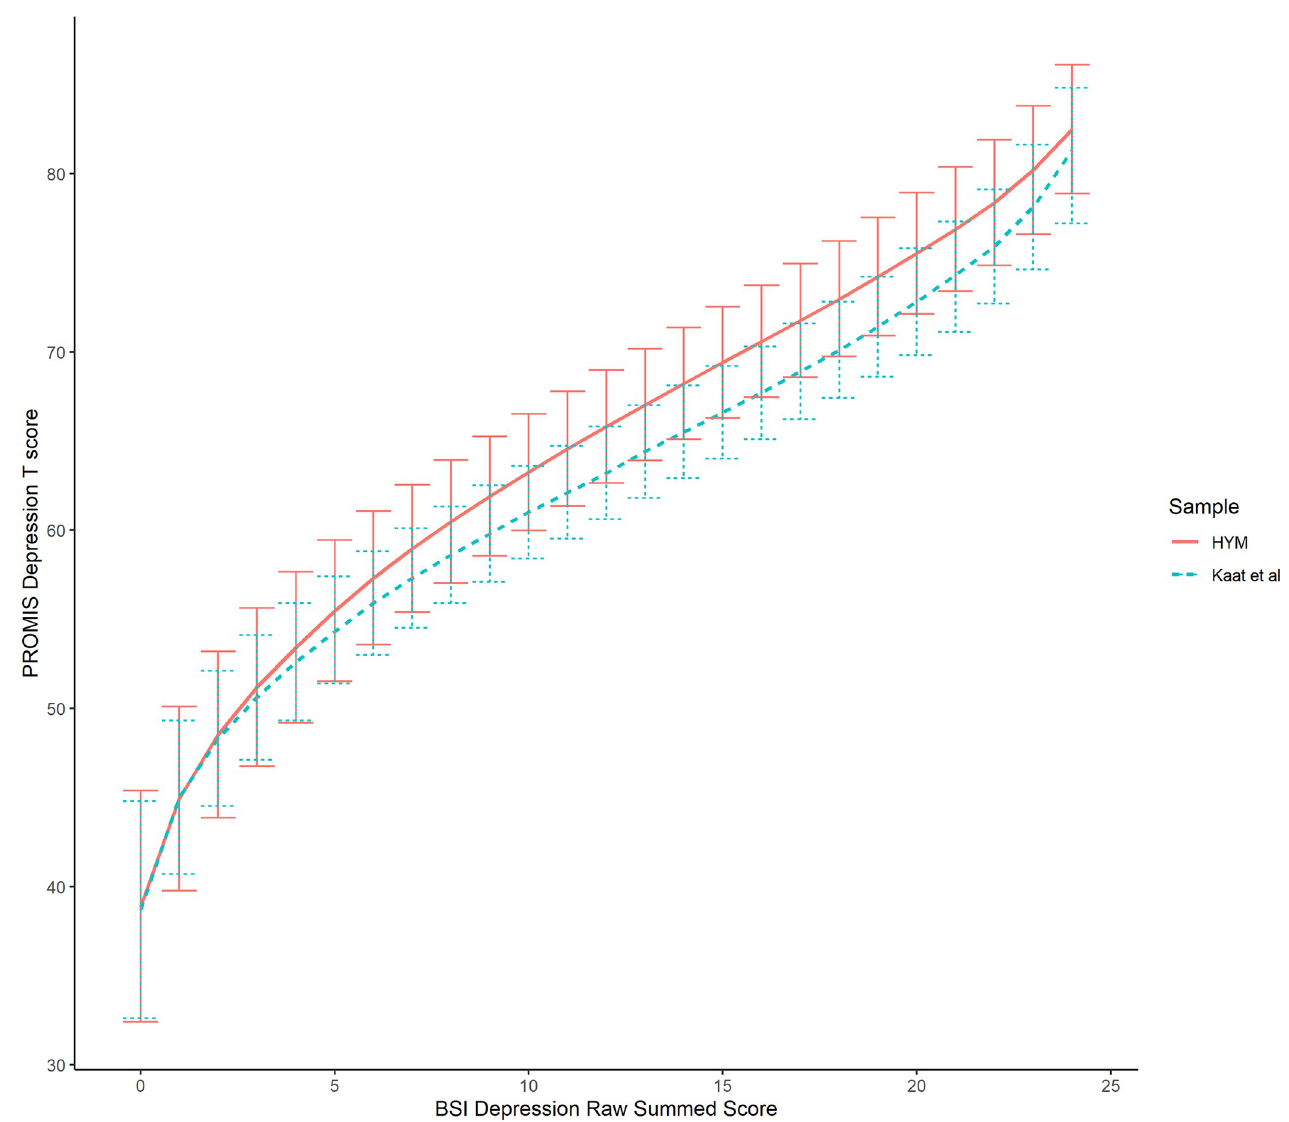
Fig 2. The crosswalks computed from the HYM sample and the Kaat et al.